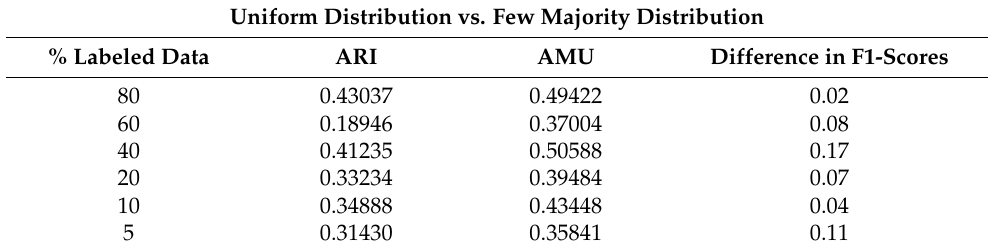
Table 15. ARI, AMU and difference in F1-scores for uniform distribution vs. few majority distribution. Uniform Distribution vs. Few Majority